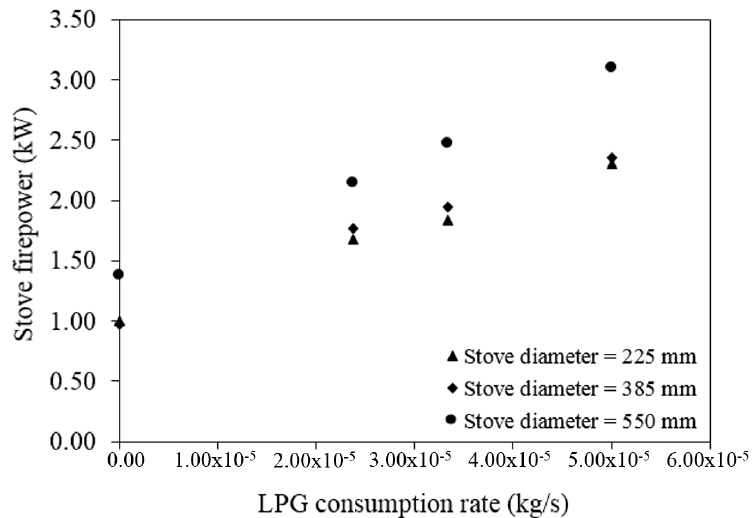
Figure 5. Relationship between firepower and LPG flow rate.